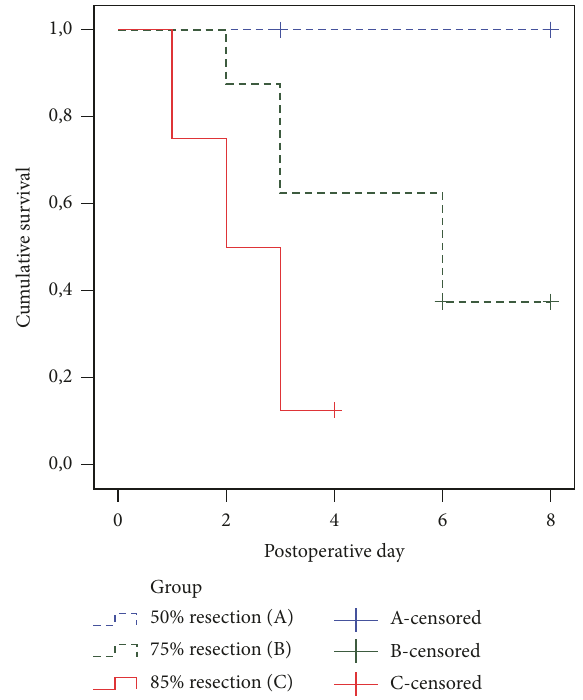
Figure 4: Kaplan-Meier survival graphs of the study groups. Survival rates were significantly different in three study groups (log- rank test 𝑝 < 0.001 ). Censored cases died due to unknown causes or were alive at the end of the follow-up